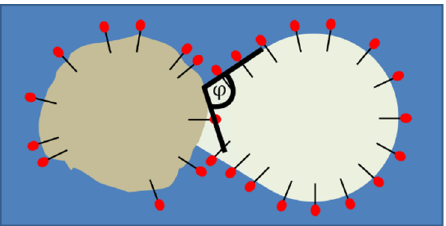
Table 4. Classification of CMN based on the wetting angle ϕ . The differentiation is made based on whether nucleation occurs or not. Additionally, a schematic abstraction and the experimental observation are shown. In the abstraction, solid structures are light brown (left particle), and liquid droplets (right) are visualized in white. For the experimental illustration, solid structures are either light white, in cases where crystallization had just taken place, or dark gray. The liquid droplet volume is represented by the transparent parts. We assumed that solid–liquid interfaces are partially composed of surfactant. In the case of ϕ = 0 ◦ , hug, the red circle highlights the part of the liquid droplet that has already crossed the solid particle and appears directly behind the latter. The first two rows illustrate that contact occurred when the surfactant was supported in the continuous phase; the last two rows show wetting angles for the initial surfactant support in the dispersed phase.